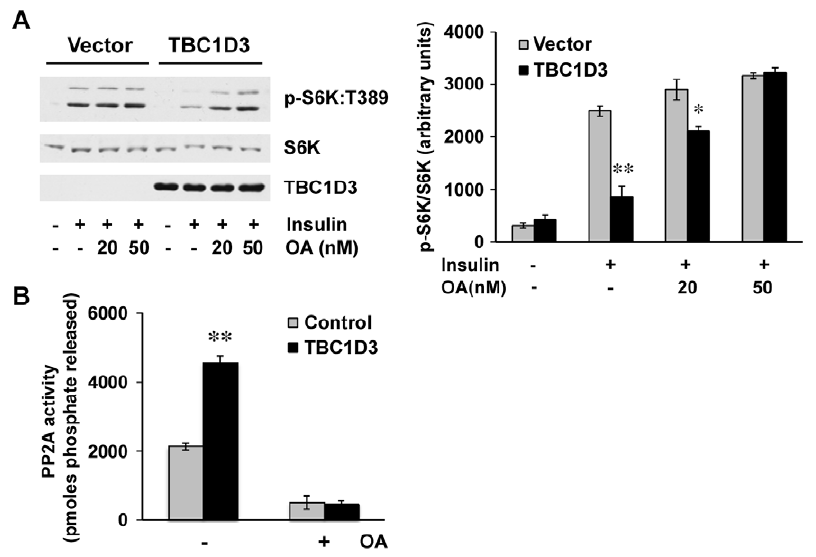
Figure 5. PP2A activity is increased in TBC1D3-expressing cells. (A) HepG2 cells transfected with myc-TBC1D3 or empty vector were serum- starved, and pre-treated with OA at various concentrations for 30 min, prior to insulin stimulation. Phosphorylation and protein levels of S6K were analyzed by Western blotting. ( Right panel ) Quantification data of S6K:T389 phosphorylation normalized to S6K protein levels (* p , 0.05, ** p , 0.01). (B) HepG2 cells transfected with myc-TBC1D3 or empty vector were serum-starved, and pre-treated with or without OA (50 nM) for 30 min before insulin stimulation. PP2A activation was assayed in vitro using the synthetic phosphopeptide K-R-pT-I-R-R, as described in Experimental Procedures (** p , 0.01). The data are presented as means 6 SD of three independent experiments.